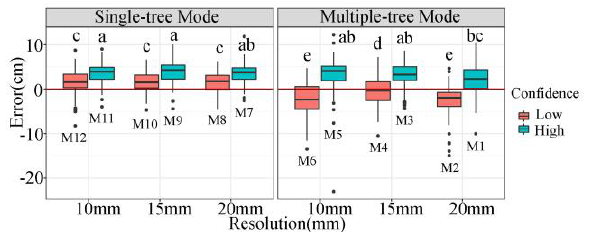
Figure 5. Boxplot for estimating DBH error using iPad Pro with different settings. Significant difference analysis among 12 methods were shown in the graph. Letter a, ab, bc, c, d, and e presented the significance levels (if two variables have different letters, they are significantly different). M is an abbreviation of